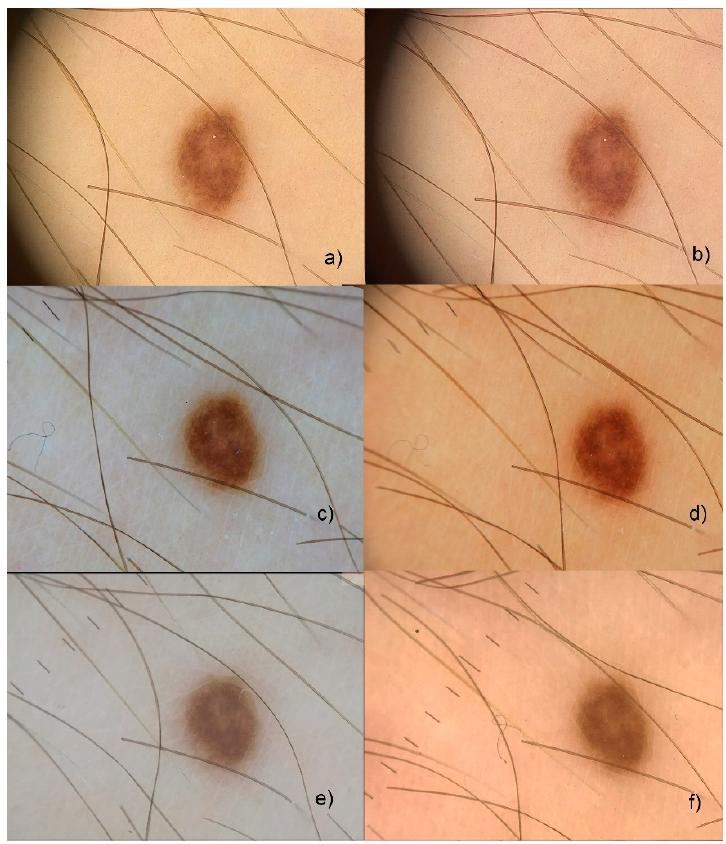
Figure 12. Skin mole dermoscopy images captured on ( a ) Fotofinder Medicam 1000s (factory settings), ( b ) Fotofinder Medicam 1000s with colour correction, ( c ) Canon EOS 10M in auto mode, ( d ) Canon EOS M10 manual colour white balance (CWB) setting, ( e ) iPhone 7 in auto mode, and ( f ) iPhone 7 manual CWB setting.